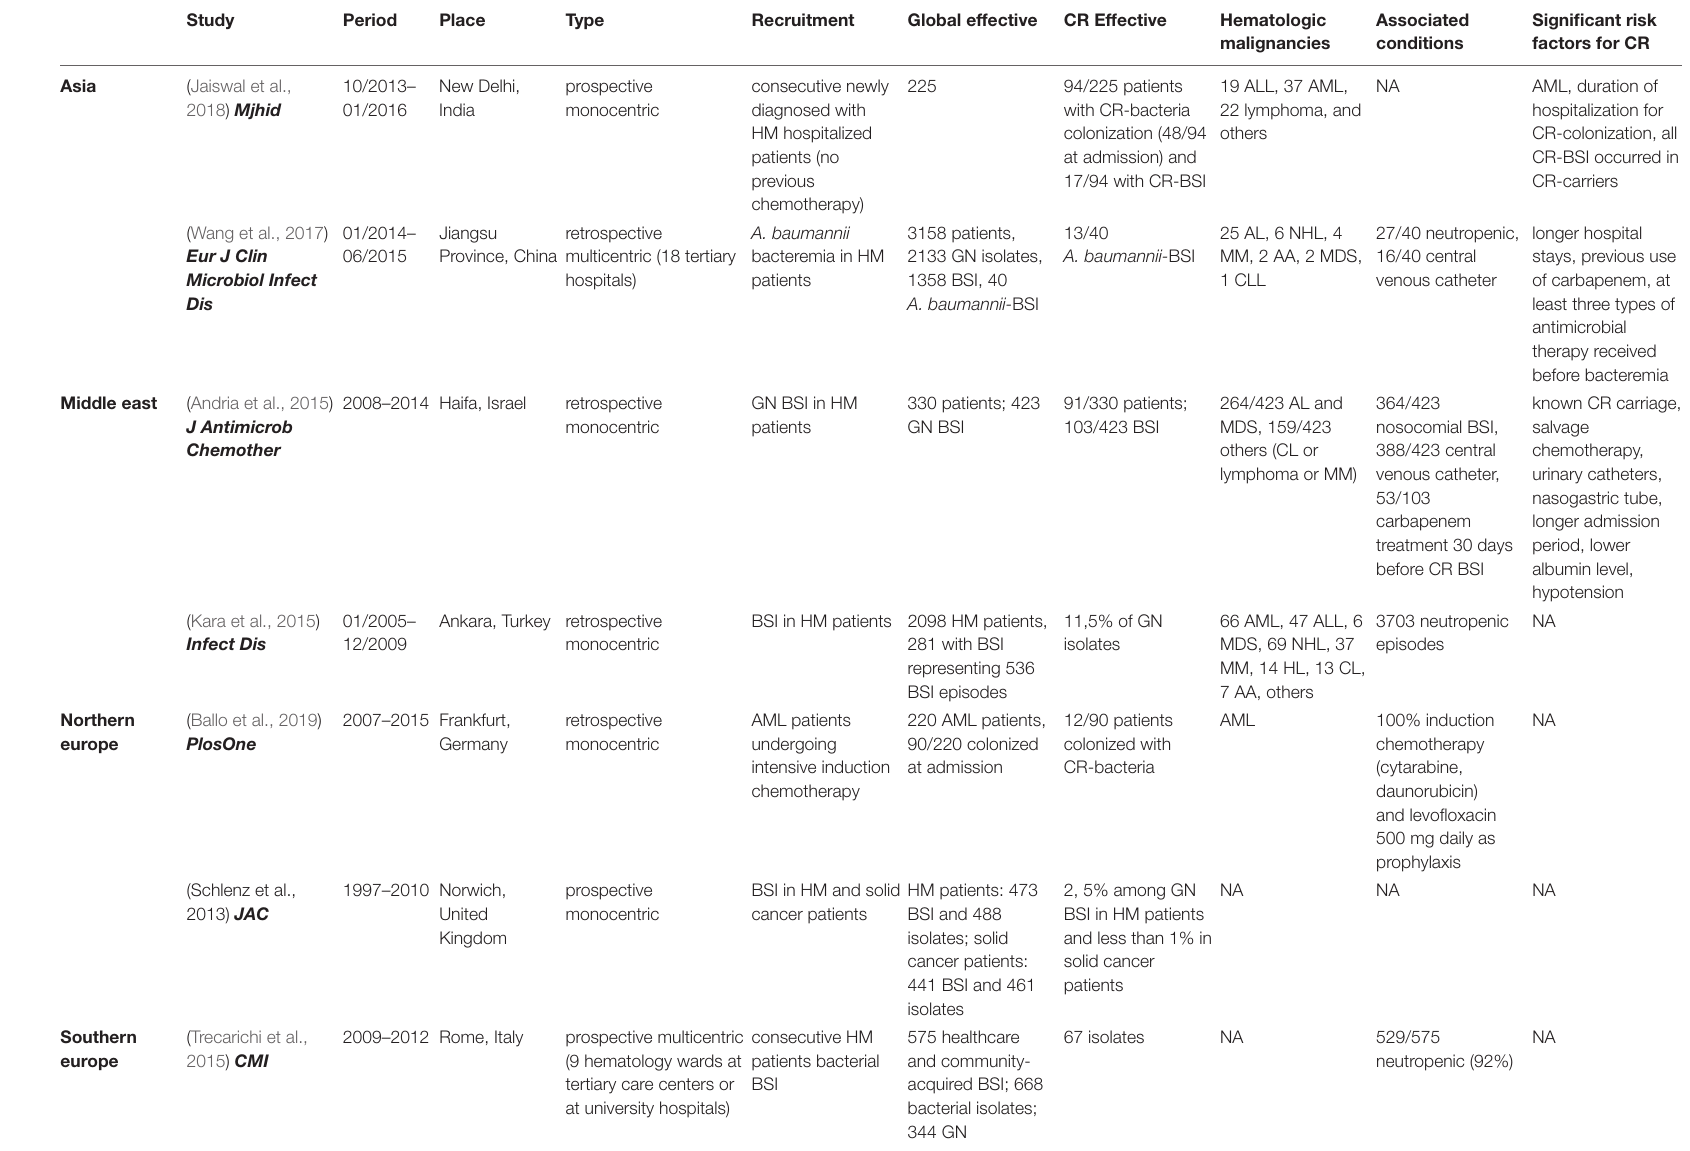
TABLE 1 | Characteristics of the studies reporting factors associated with CR bacteria in HM patients.